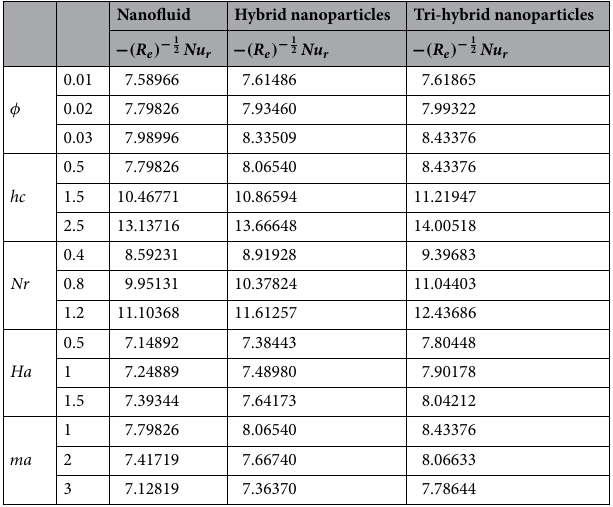
Table 4. Comparison imitations among NF, HNFs and tri-HNFs of Nusselt